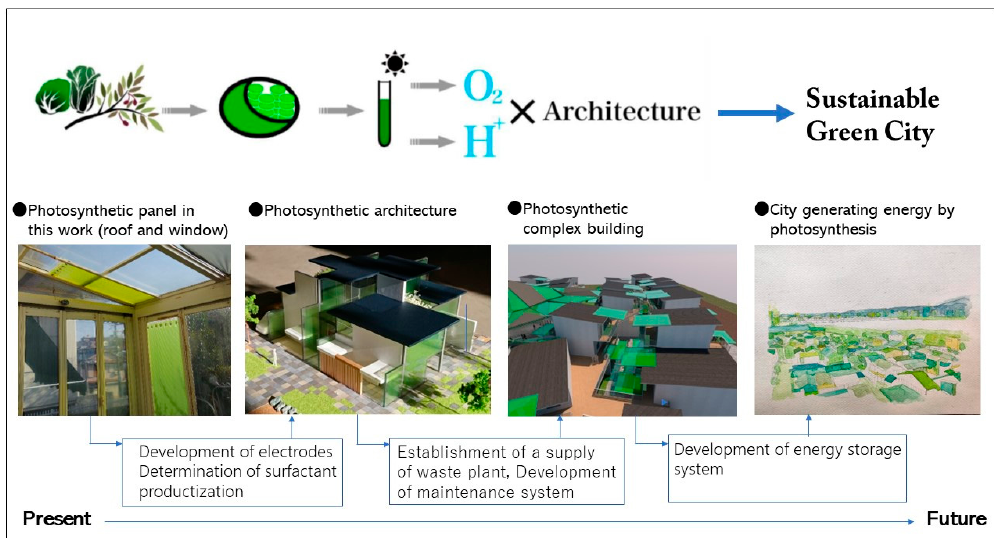
Figure 13. Architectural model with photosynthetic panels applied to the walls.